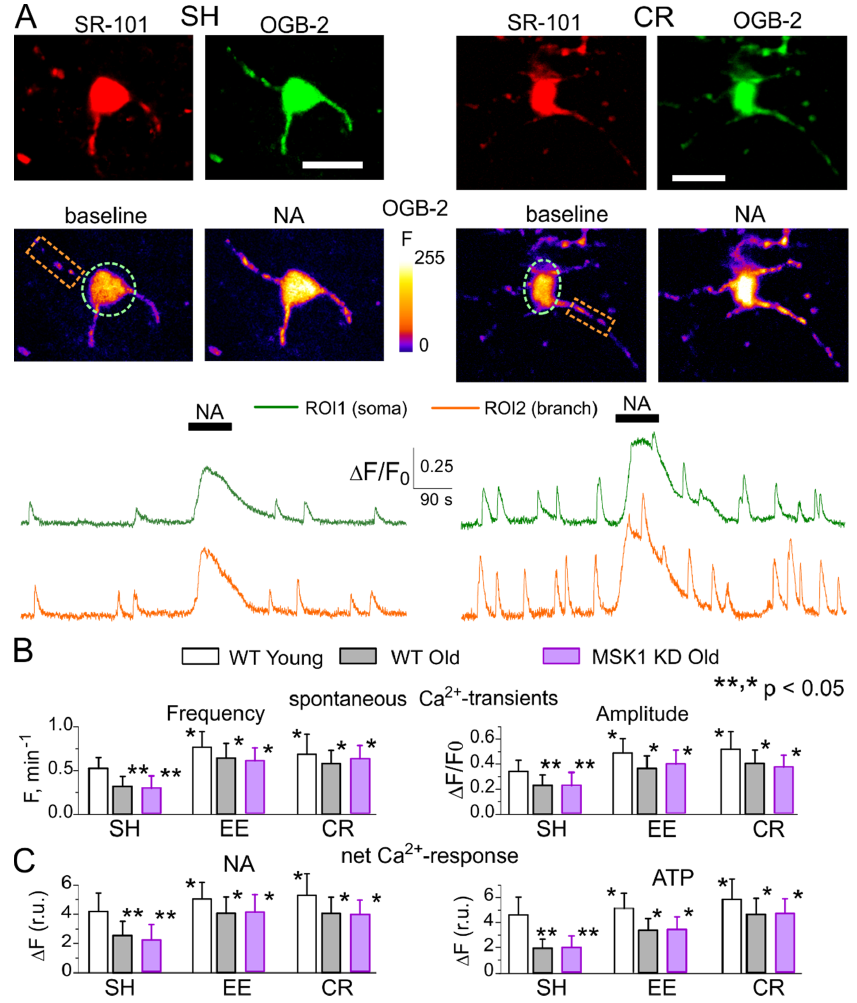
Figure 3. Age- and experience-related changes in the astrocytic Ca 2+ signalling. Astroglial Ca 2+ signalling was evaluated in the neocortex of 6–12 week-old (young) and 9–15 month-old mice (old). The MSK1 KD and their wild-type littermates were kept either in standard housing (SH) or exposed to environmental enrichment (EE) or caloric restriction (CR) as described in the Methods . ( A ) Representative multi-photon images of astrocytes of old MSK1 KD mouse pre-loaded with OregonGreen BAPTA-2 AM and stained with fluorescent astroglial marker SR101 and presudo- colour images of OGB-2 fluorescence recorded before and after application of noradrenaline (NA, 1 µM). Graphs below show the time course of OGB-2 fluorescence averaged over regions indicated in the fluorescent images. Note the increase in the amplitude of spontaneous in the Ca 2+ -elevations and response to NA. ( B ) The pooled data on peak amplitude and frequency of the baseline spontaneous Ca 2+ - transients recorded in astrocytes of WT and MSK1 KD mice of different age and treatment groups. Number and size of spontaneous events were pooled for the whole cell image. ( C ) The pooled data on the net cell responses to application of 1 µM noradrenaline and 10 µM ATP. Data in the panels ( B , C ) are shown as mean ± SD for the 6–12 astrocytes from 3–4 animals. Asterisks (*, **) correspondingly indicate statistical significance of the effect of EE- or CR-treatment (as compared to SH) and difference between the old and young mice of the same treatment group. Note the significant increase in the spontaneous and evoked Ca 2 + signalling in astrocytes of mice exposed to EE and CR and the lack of difference in the Ca 2 + signalling in the WT and MSK1